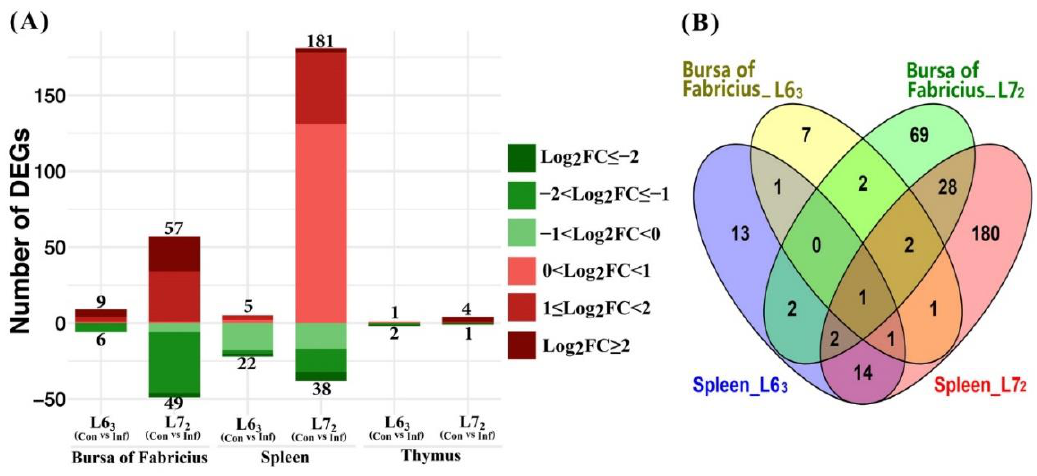
Figure 3. Differentially expressed mitochondria-related nuclear genes in response to Marek’s disease virus (MDV) challenge (FDR ≤ 0.1). ( A ) Number of up- or down-regulated DEGs in three lymphoid organs. Up-regulated and down-regulated genes are displayed in red and green color, separately. Color density indicates different range of Log 2 (fold change) (log 2 FC). ( B ) Venn diagram showing the number of overlapped DEGs in bursa of Fabricius and spleen from line 6 3 and 7 2 .